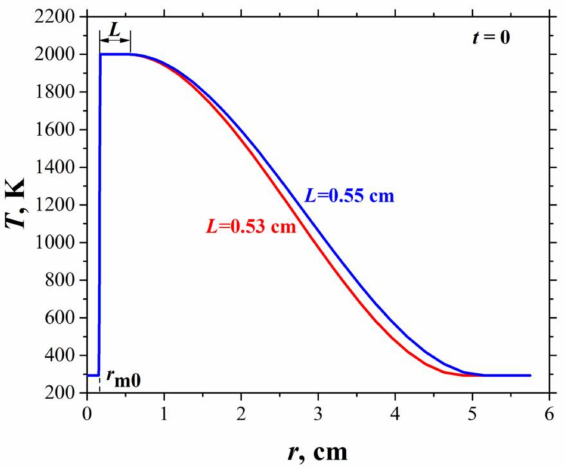
Figure 9. An example of setting the initial temperature fields T l 0 ( r ) and T g 0 ( r ) for the n-dodecane droplet with D 0 = 2.8 mm ( r m 0 = 1.4 mm) at NPT